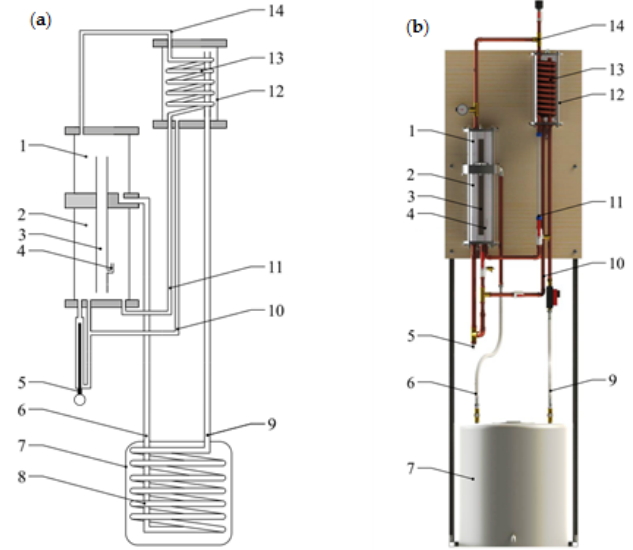
Figure 8. Diagram of the laboratory stand for testing a reverse thermosiphon with two working media: